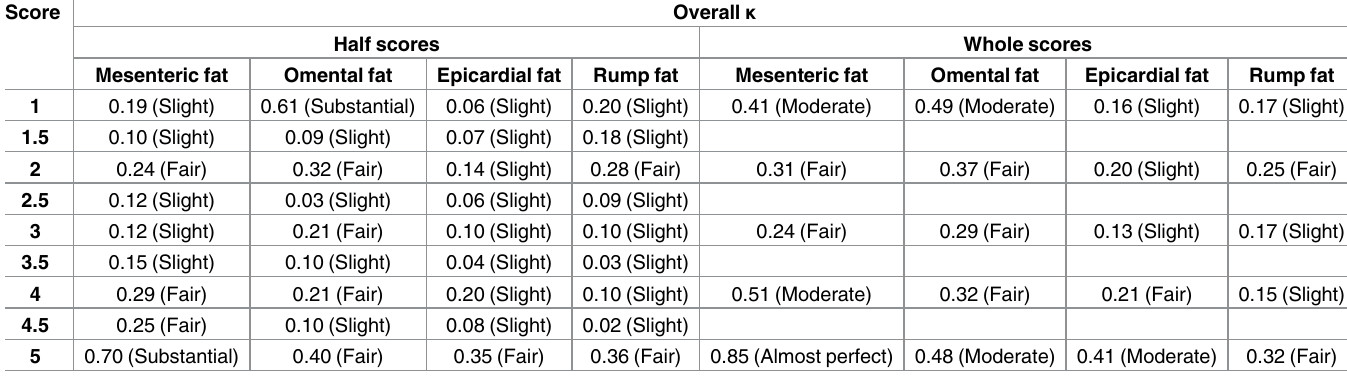
Table 5. Repeatability of individual EQUIFAT scores for each